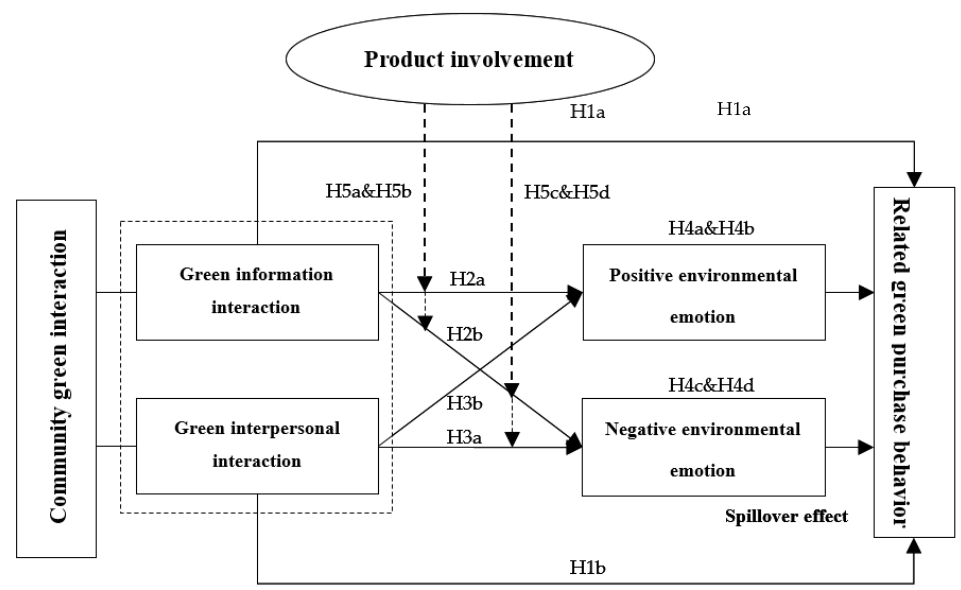
Figure 1. Hypothetical model of spillover effect of community green interaction.